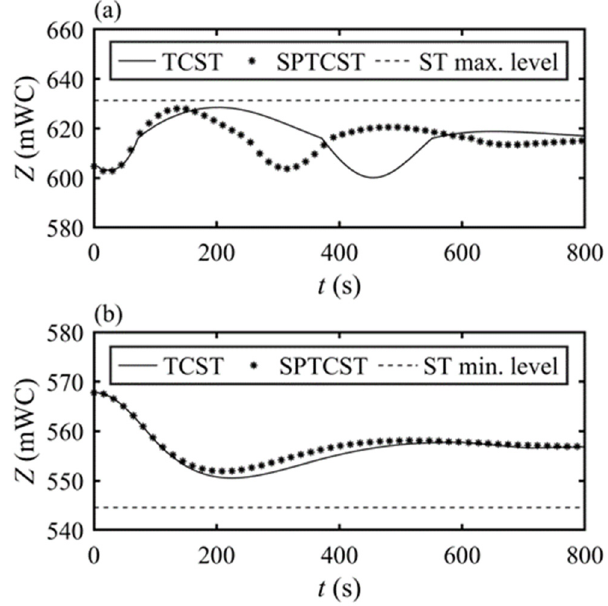
Figure 10. STWL for the throttled chamber and optimized semi-pneumatic throttled chamber surge tank for ( a ) load rejection and ( b ) simultaneous start of both turbines.